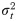
Threshold crossing of a regulated molecular species.(A) A target species X is regulated by either an accumulating activator A or a degrading repressor R. (B) Temporal precision is quantified by the variance σt2 of the first-passage time, at which the stochastic molecule number x first crosses the threshold x*. (C, D) Deterministic dynamics illustrate the effects of regulation. Parameters are kt* = 20 and K = 15 in C; μt* = 2.75, K = 2.6, and N = 15 in B and D; and x* = 15 and H = 1 throughout. t0 is defined by a¯(t0)=K in C and r¯(t0)=K in D.